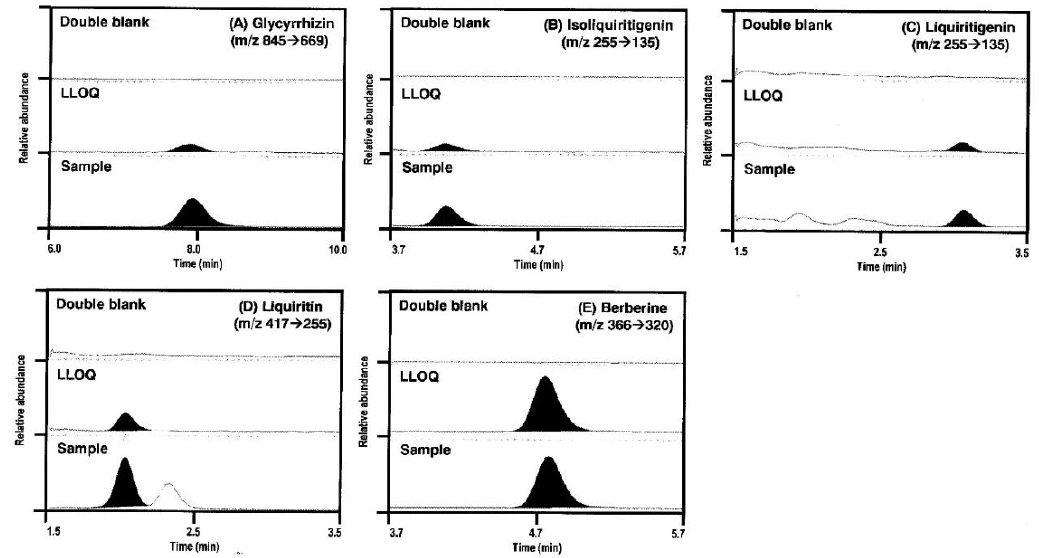
Figure 2. Representative multiple reaction monitoring (MRM) chromatograms of ( A ) glycyrrhizin, ( B ) isoliquiritigenin, ( C ) liquiritigenin, ( D ) liquiritin, and ( E ) berberine (IS) in rat double blank plasma (upper), rat blank plasma spiked with standard solution at lower limit of quantification (LLOQ) (center), and rat plasma samples at 2 h following single oral administration of Glycyrrhizae Radix extract (GRE) (1 g/kg) (lower).